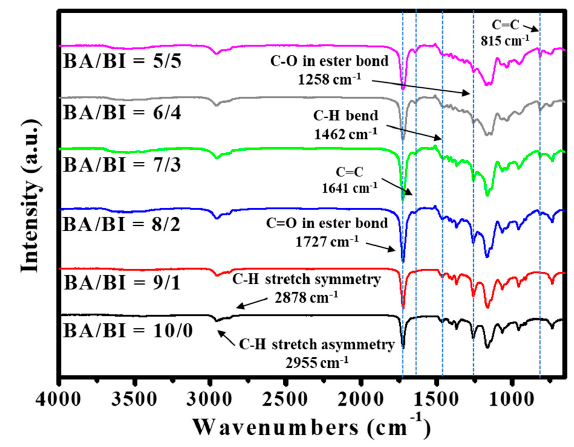
Figure 2. FT-IR spectra of PBABI copolyesters with different BA/BI ratios.